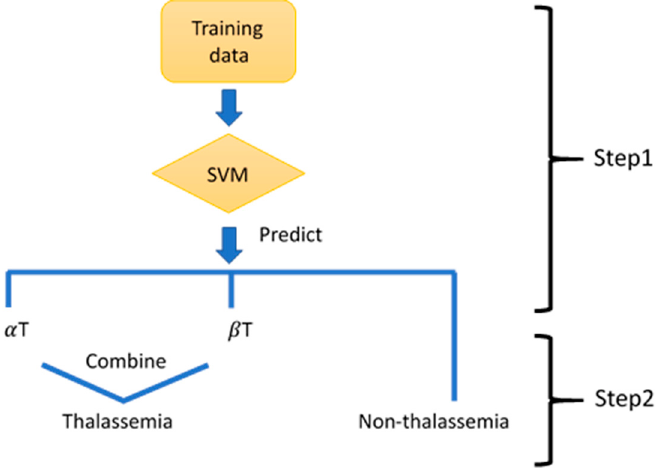
Figure 1. The diagram of building the classifier performing binary classification. Support vector machine (SVM), alpha-thalassemia ( α T), beta-thalassemia ( β T). machine (SVM), alpha-thalassemia ( α T), beta-thalassemia ( β